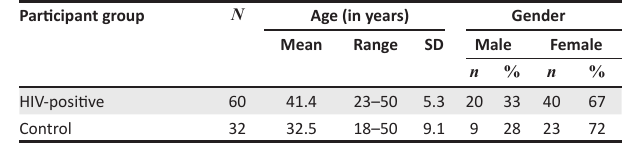
TABLE 1: Participants’ description. Participant group